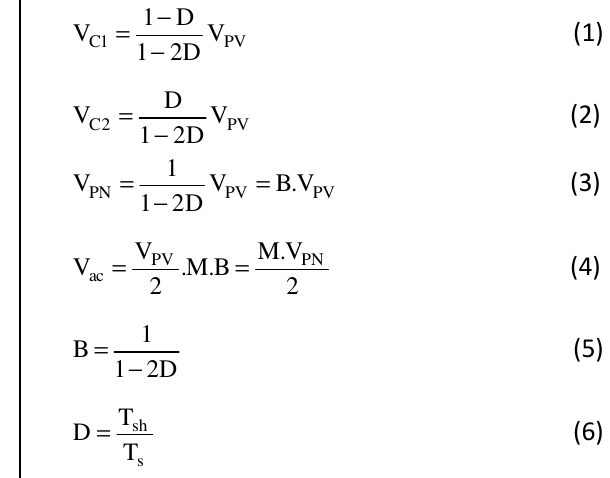
where, D is the shoot through duty ratio, B is the boost factor, V PV is the PV input voltage, M is the modulation index, V PN is the DC link voltage and T S 9is the switching time